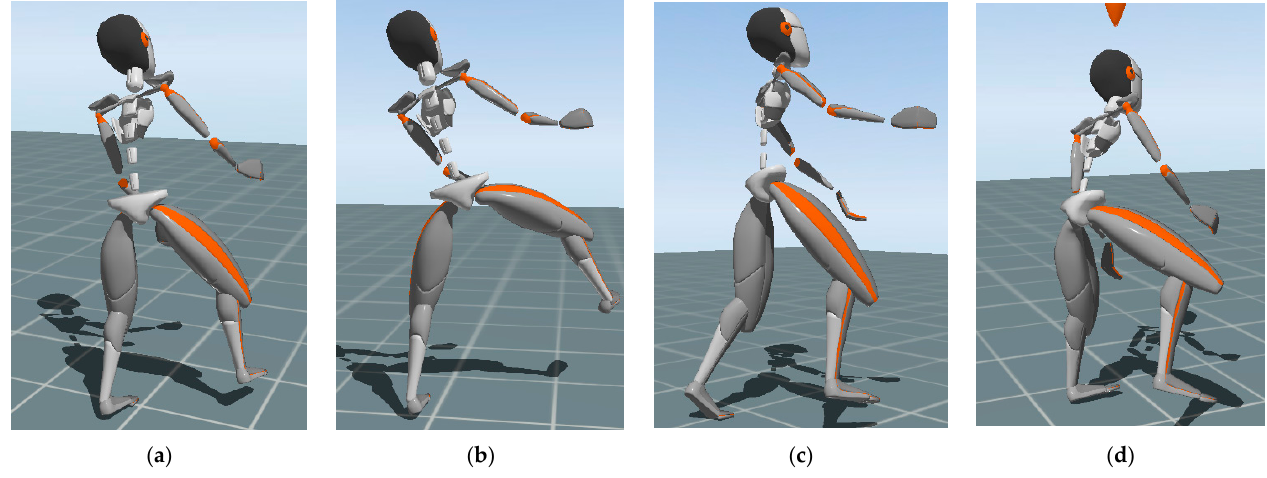
Figure 6. Different mowing patterns of “typical mowing” on the slope. ( a ) Basic mowing. ( b ) Stride mowing. ( c ) Moving mowing. ( d ) Downward mowing. mowing. ( c ) Moving mowing. ( d ) Downward